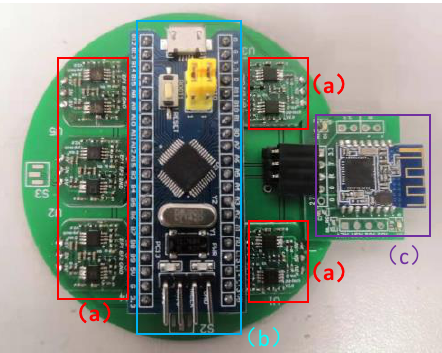
Figure 19. Hardware system physical diagram.(a) signal conditioning circuit;(b) STM32 minimal system board;(c) Bluetooth communication module system board; (c) Bluetooth communication module.